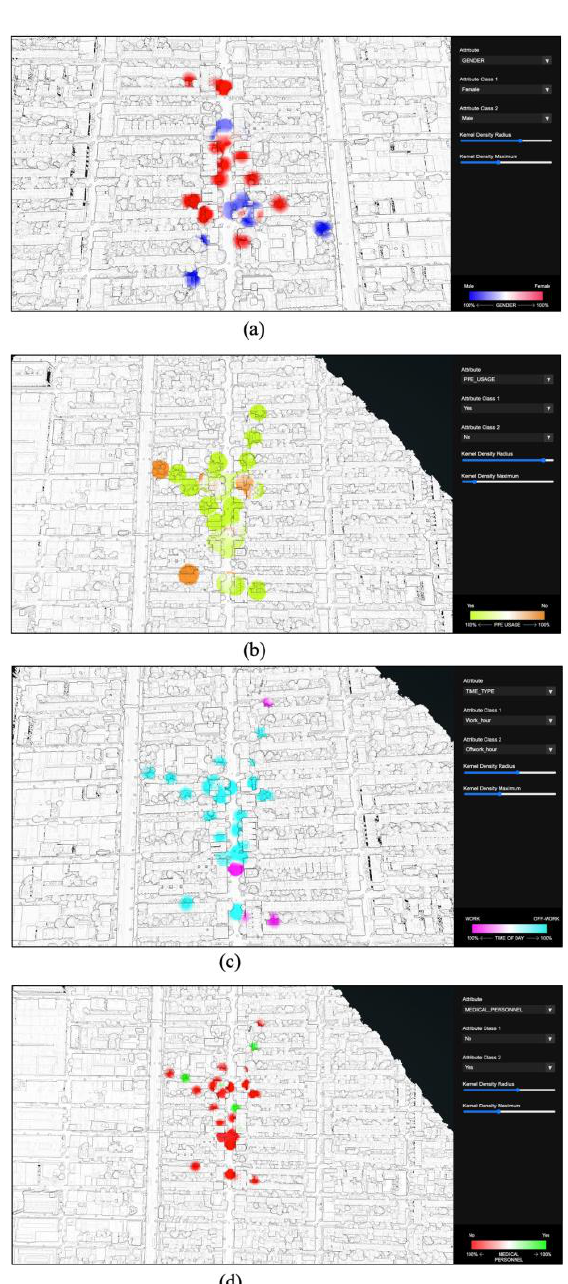
Figure 5. Hotspot heatmap for feature (a) “Gender” Male in blue and female in red (b) “PPE Usage” Individuals wearing PPE in green and not wearing PPE in orange (c) “Time Type” Working hour visitors in magenta and off-work hour visitors in cyan (d) “Medical Personnel” Medical personnel in green – others in